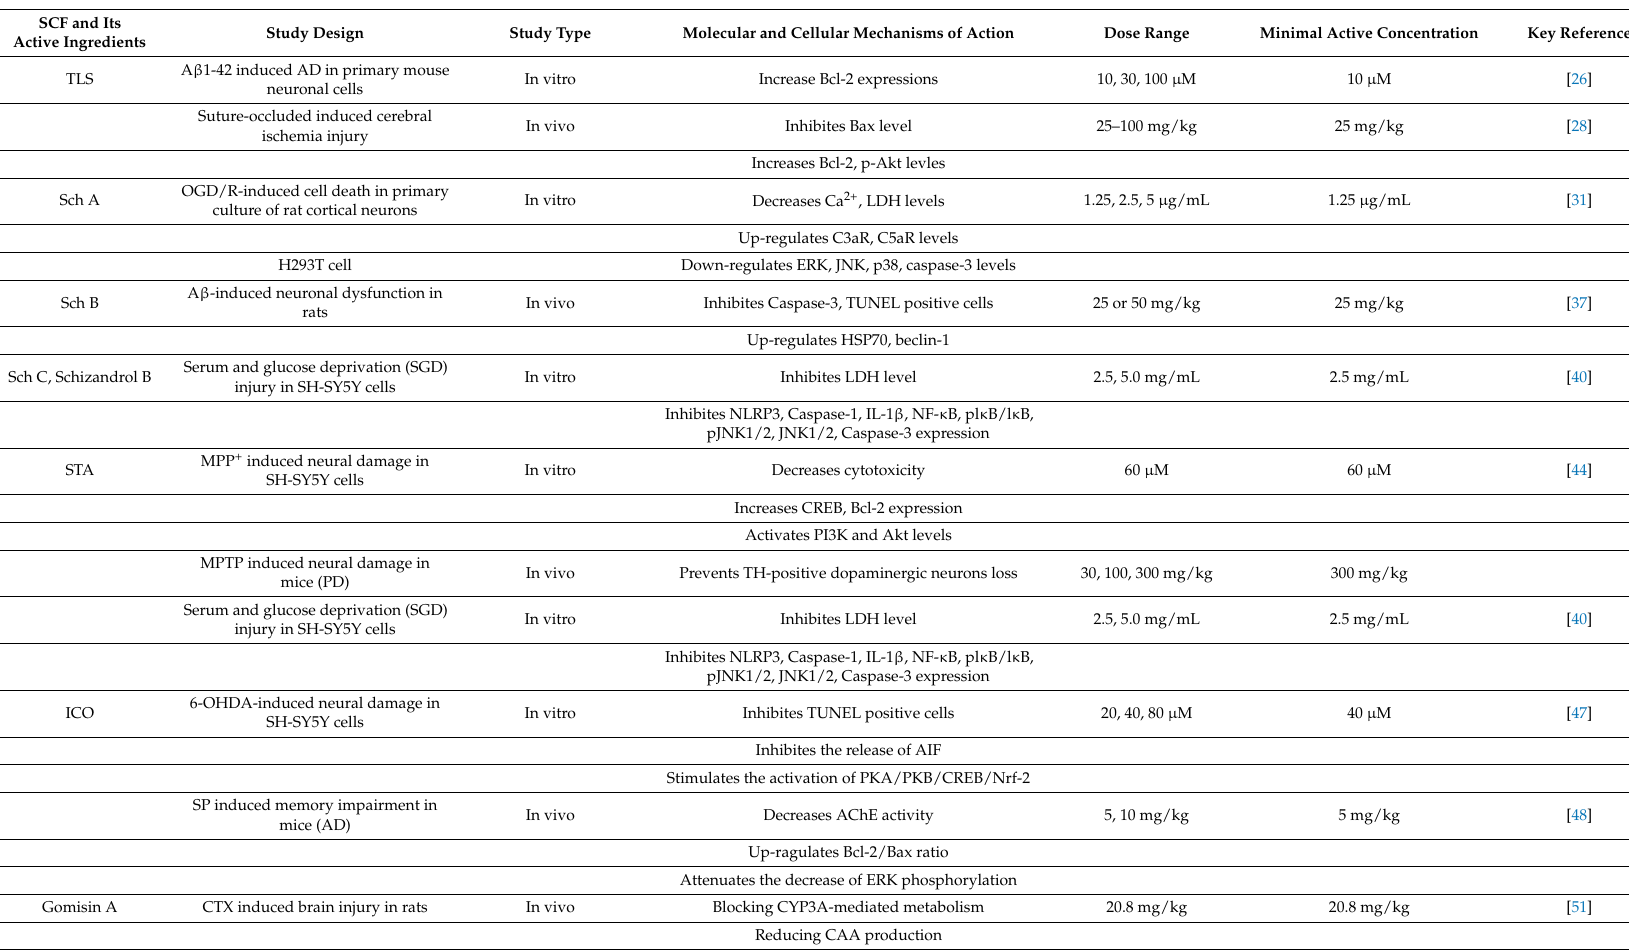
Table 3. The pharmacological data of SCF and its active ingredients in protecting against NDs by suppressing apoptosis. TUNEL—terminal transferase-mediated dUTP nick-end labeling; OGD/R— oxygen and glucose deprivation followed by